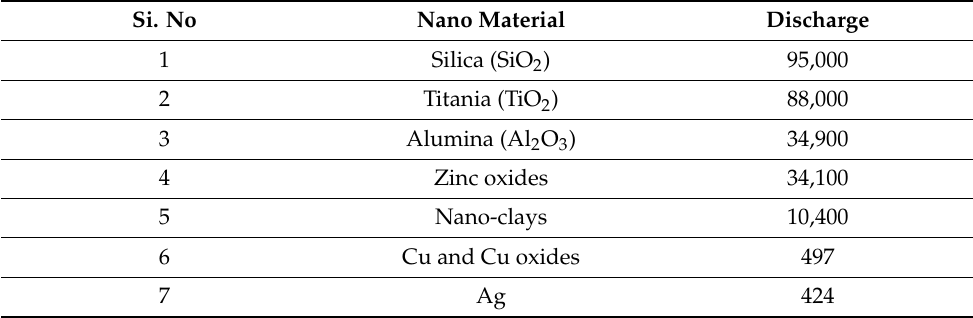
Table 1. Nanomaterials and discharges (reprinted with permission from